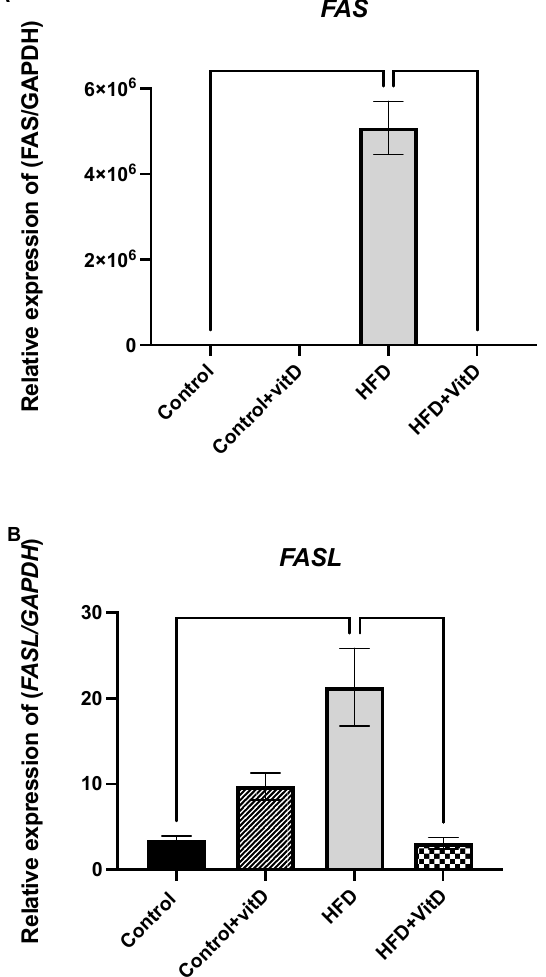
Figure 2. Gene expression of the extrinsic apoptotic signaling genes. ( A ) The gene expression of FAS in rats fed a normal diet (Control), a high-fat diet (HFD), and a vitamin D-supplemented HFD (HFD + VitD). FAS was increased in the group fed with HFD ( p ≤ 0.0001) compared with the control. Combining vitamin D with HFD caused this gene to be significantly downregulated ( p ≤ 0.0001). ( B ) The gene expression of FAS ligand (FASL). The HFD increased the expression of FASL in comparison to the control ( p ≤ 0.0001). Combining vitamin D with the HFD significantly downregulated this gene in comparison to the control ( p ≤ 0.0001). Data were normalized to the reference gene GAPDH. All data were expressed as mean ± SEM. Data were considered significant if p <